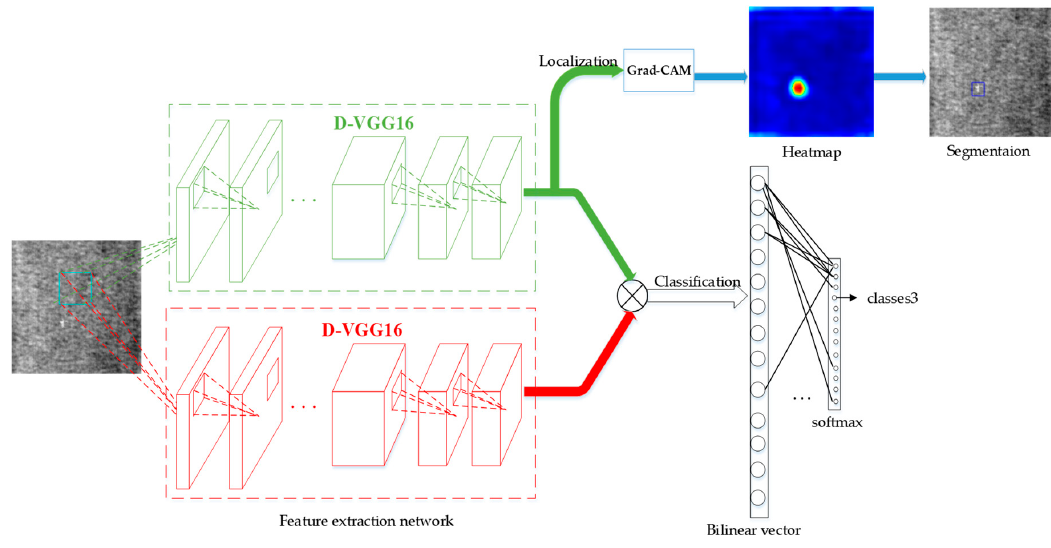
Figure 1. Network overall structure.